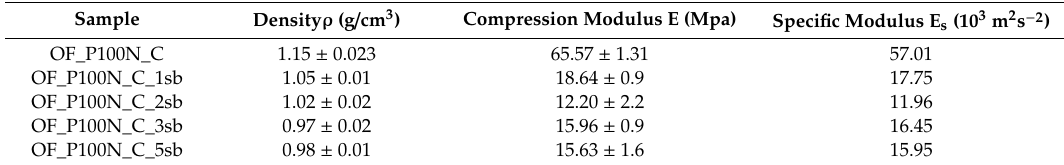
Table 3. Compression modulus, density, and specific modulus of the OF_P100N_C samples with di ff erent amounts of sodium